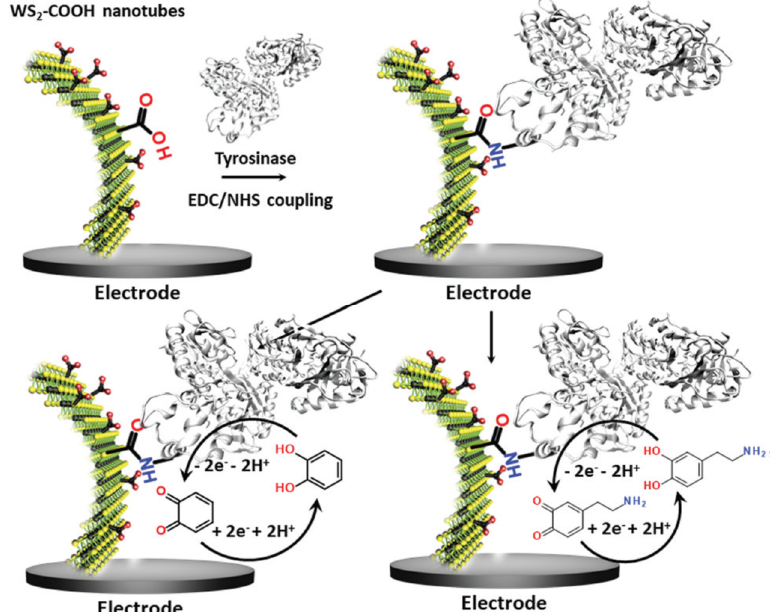
Figure 3. Sketch of the functionalization of WS 2 modified glassy carbon electrodes with the enzyme tyrosinase via a standard EDC/NHS coupling reaction. These modified bioelectrodes served in the detection of catechol (bottom left) and dopamine (bottom right) at −0.2 V vs. Ag + /Ag. (reproduced from [50] with permission of RSC Publishing).